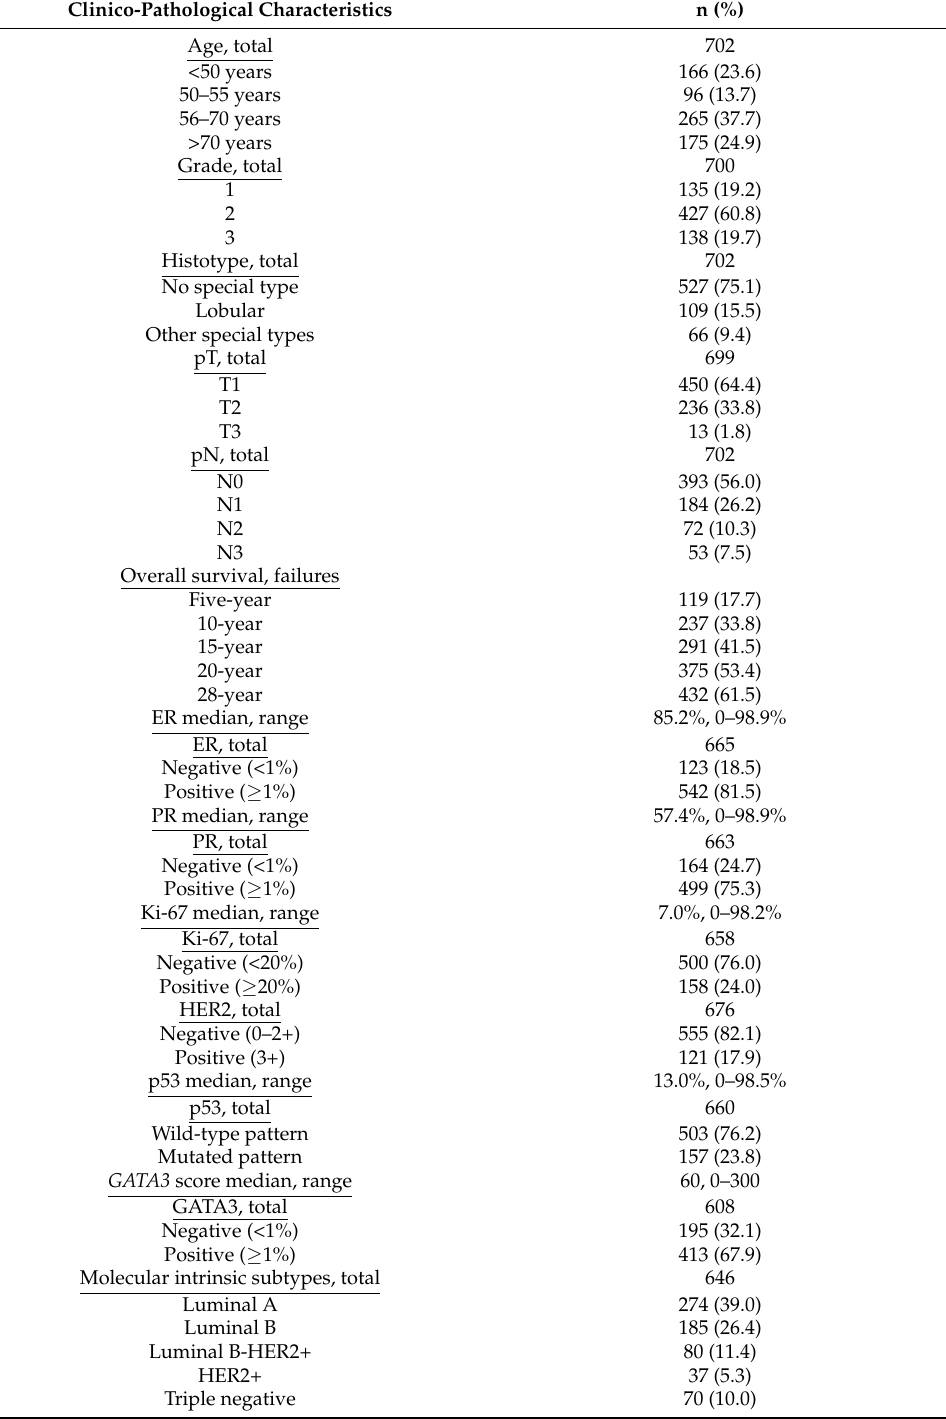
Table 1. Clinico-pathological characteristics and biological markers of breast cancer